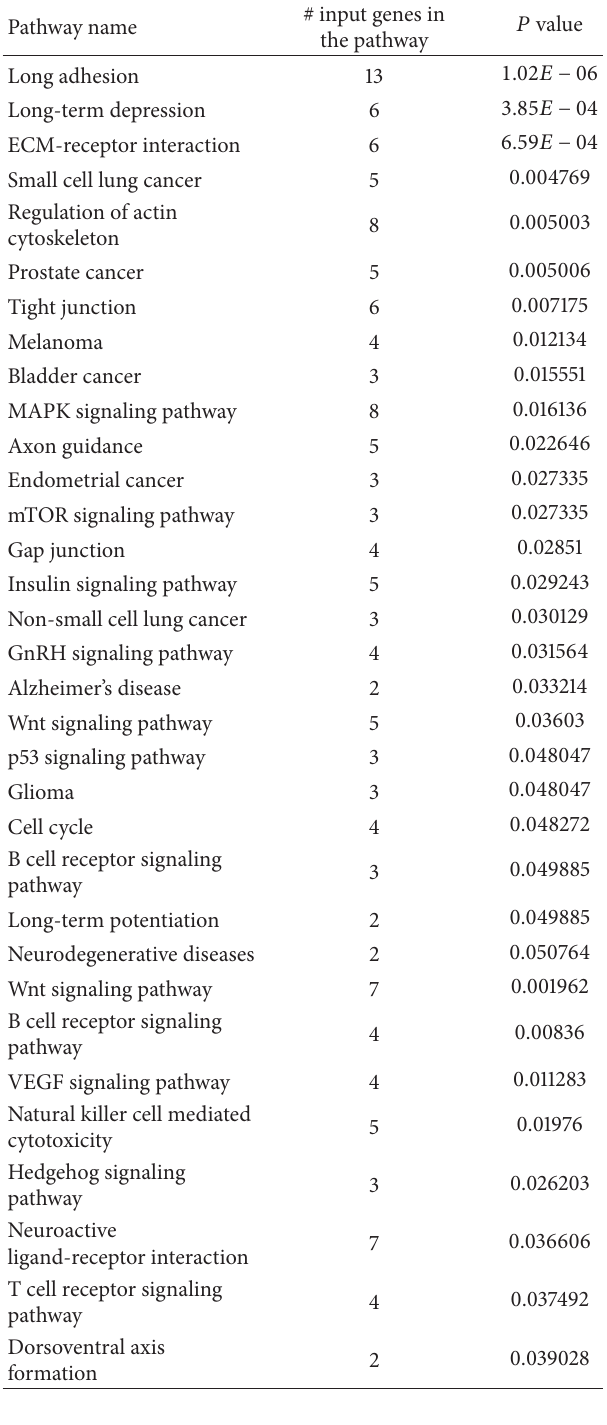
Table 1: Molecular pathways downregulated by